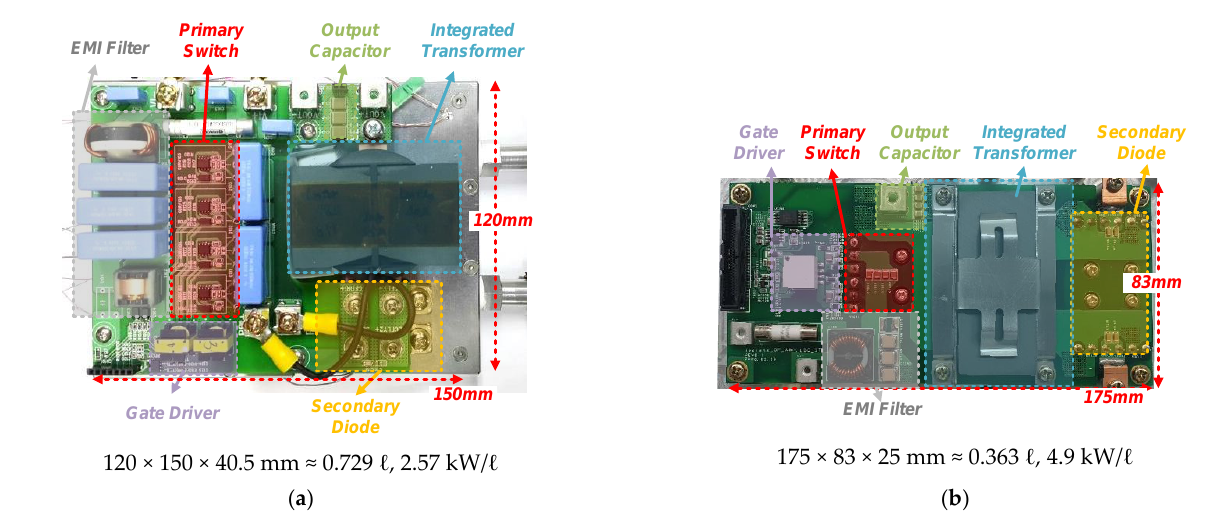
Figure 13. Prototypes of conventional and proposed converters: ( a ) Conventional FBACFF converter with integrated transformer. ( b ) Proposed ACF converter with integrated planar transformer. Table 4. Parameters of Prototype Hardware.